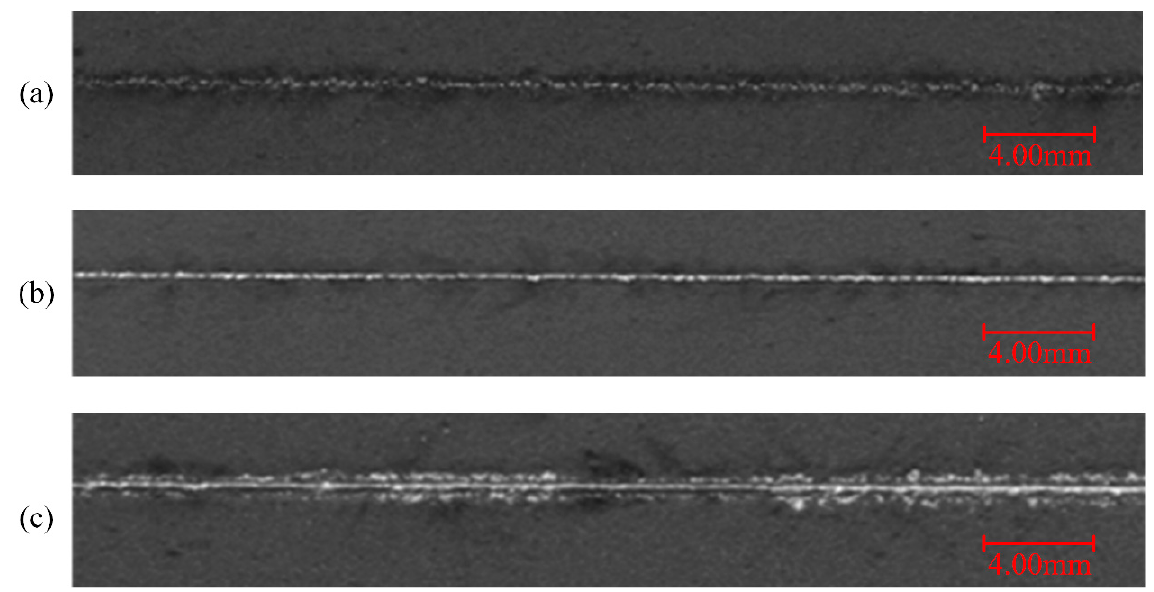
Figure 11. Morphology comparison of single tracks with different laser powers: ( a ) 25 W, ( b ) 100 W, and ( c ) 175 W. (the scanning speed is 30 mm/s).